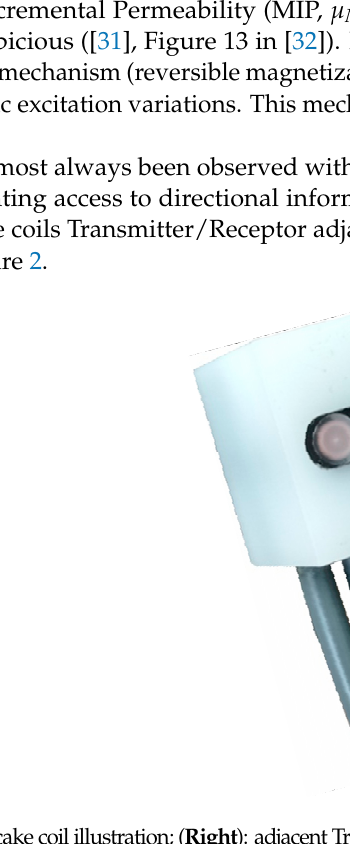
Figure 2. ( Left ): single pancake coil illustration; ( Right ): adjacent Transmitter/Receptor, TR-probes